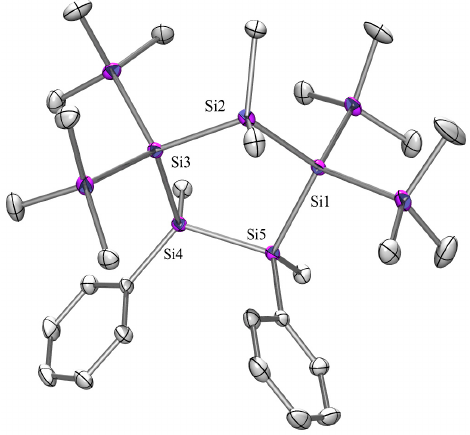
Figure 20. Crystal structure of 22 . Thermal ellipsoids are represented at the 30% level and hydrogen atoms have been omitted for clarity (bond lengths in Å, angles in deg). Si(1)-Si(5) 2.3632(8), Si(1)-Si(7) 2.3643(10), Si(1)-Si(2) 2.3684(10), Si(1)-Si(6) 2.3696(9), Si(2)-Si(3) 2.3796(10), Si(3)-Si(9)